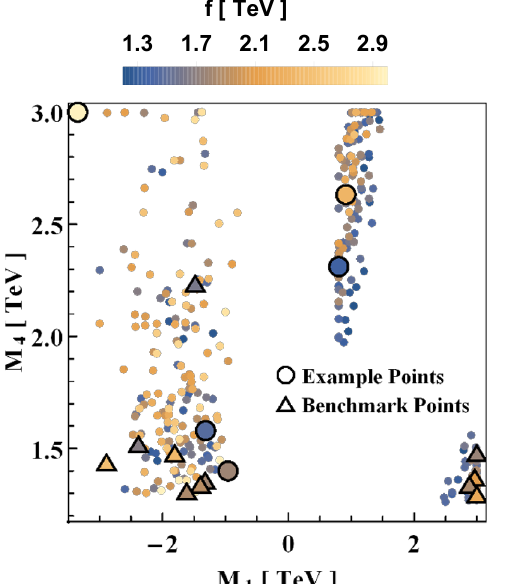
Figure 13 . Low scale scan of the MCHM 5 parameter space, including example points of table 1, benchmark points of table 5 and the points consistent with constraints in eqs. 4.1 and 4.2.